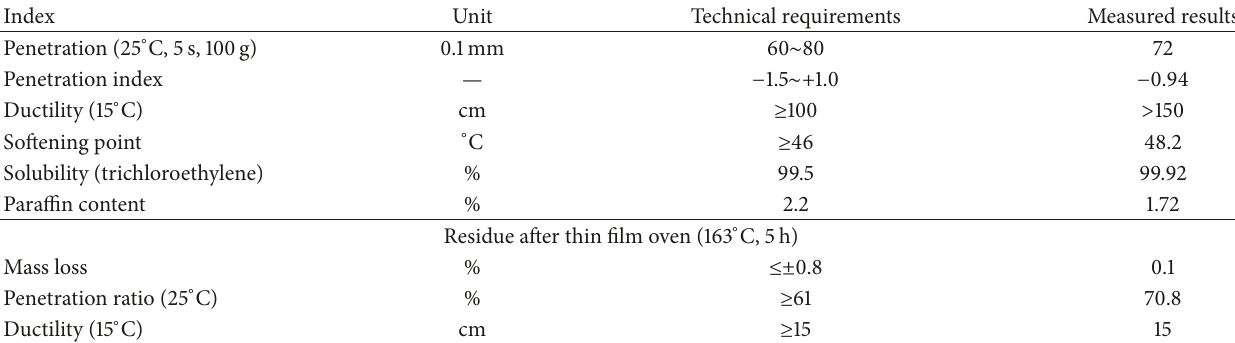
Table 2: Asphalt binder properties of SK 70 #